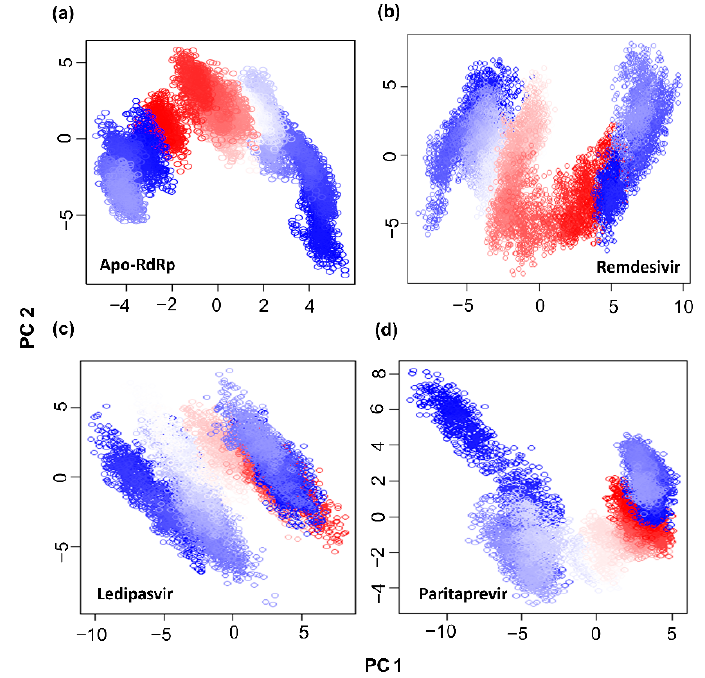
Figure 4. Projection of protein atoms in phase space along the first two principal eigenvectors. ( a ) The apo-RdRp protein; ( b ) the RdRp protein complexed with ledipasvir; ( c ) the RdRp protein complexed with remdesivir; ( d ) the RdRp protein complexed with paritaprevir.